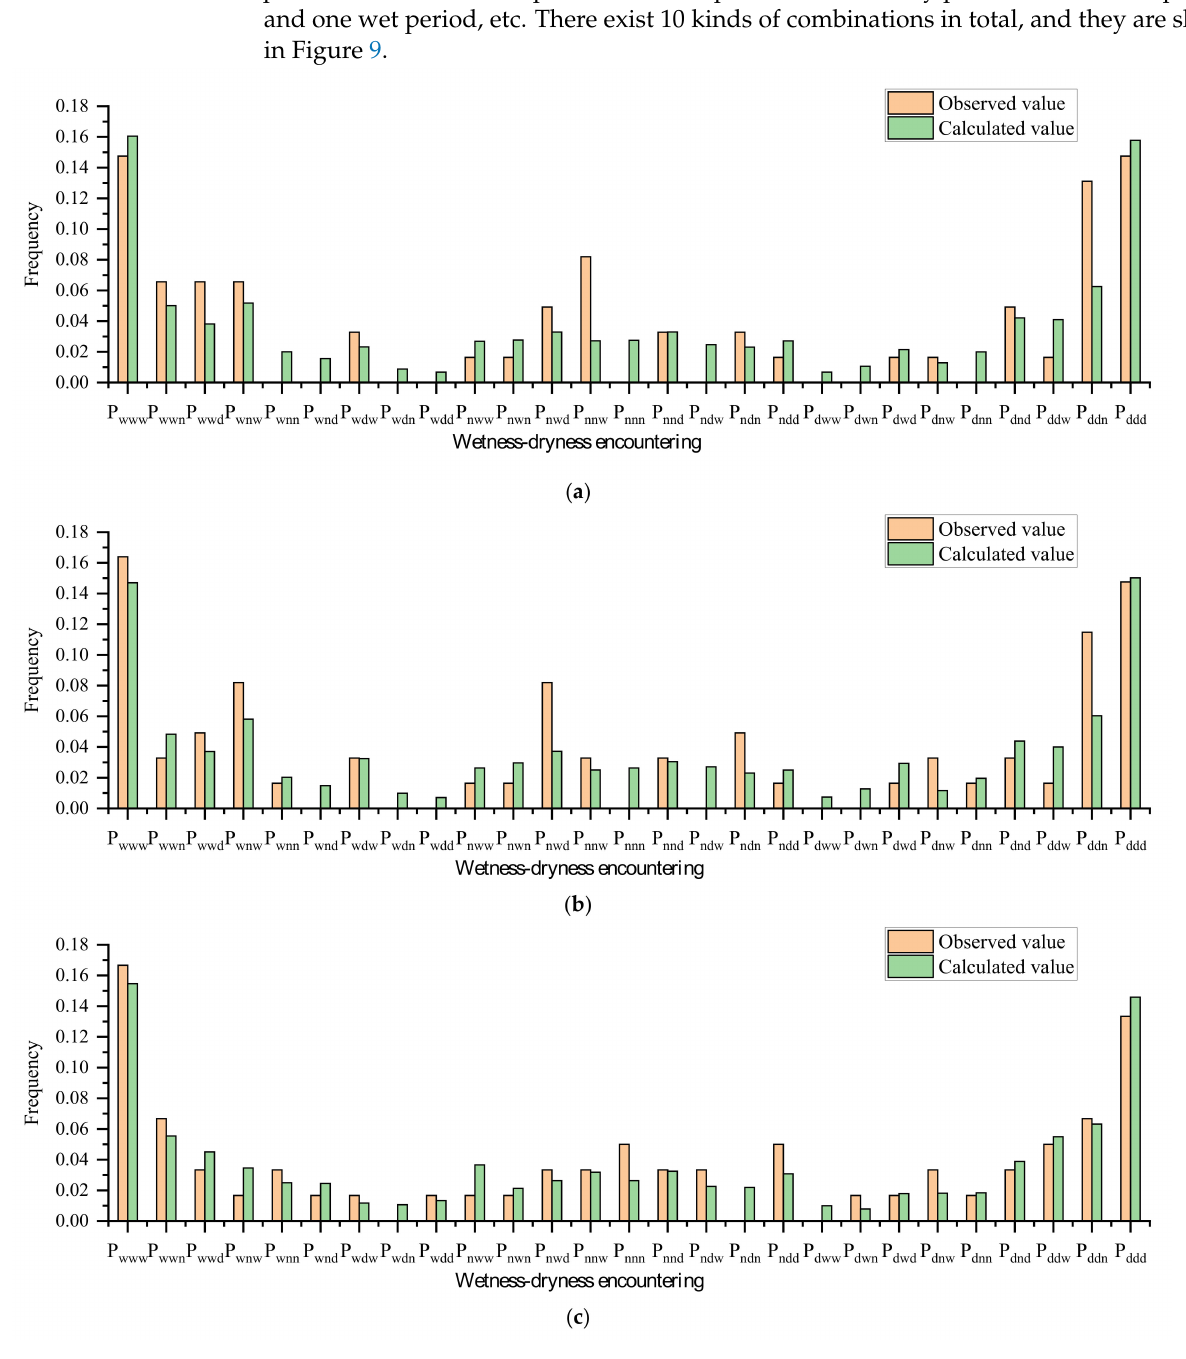
Figure 8. The observed and calculated values of frequencies of wetness-dryness encountering at three scales: ( a ) is under the annual scale; ( b ) is in flood season; and ( c ) is in non-flood